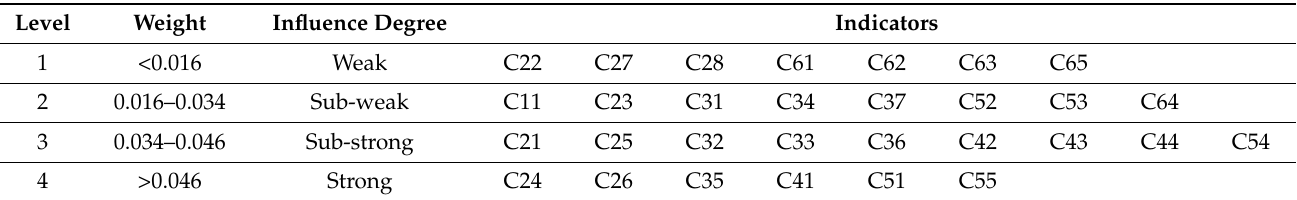
Table 4. Index influence